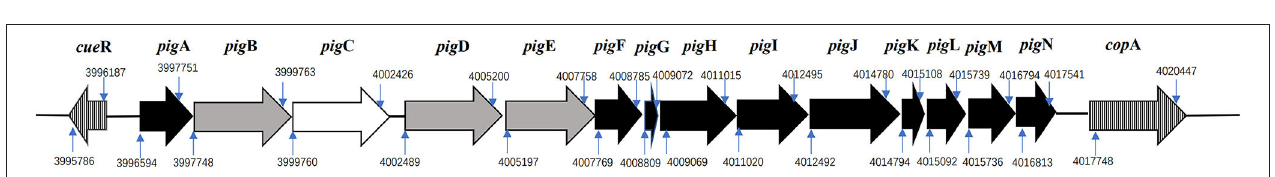
FIGURE 2 | The pig cluster of prodigiosin biosynthesis in strain ZPG19. Genes were symbolized by arrows. The white arrows denoted genes involving in condensing enzymes; black arrows represented genes encoding proteins required for the biosynthesis of the monopyrroles; gray arrows genes encoding proteins required for the biosynthesis of 4-methoxy-2,2-bipyrrole-5-carboxyaldehyde; vertical striped arrows denoted flanking genes cue R and cop A; The numbers in small blue arrows indicated the start positions and end positions of each